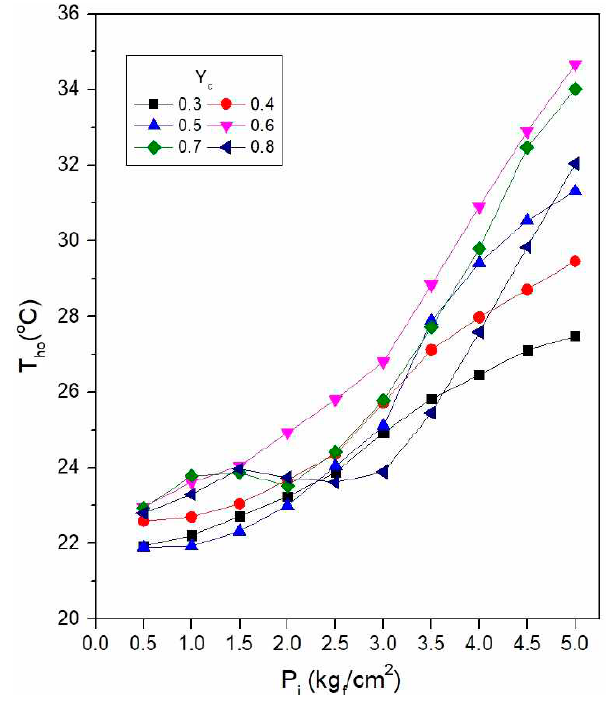
Figure 26. Direct heat exchange method of ∆ T ho according to pressure.